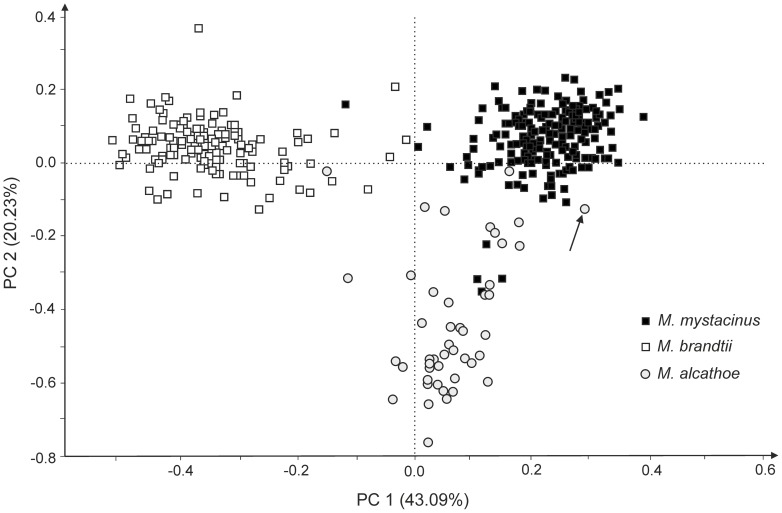
A two-dimensional plot of the principal coordinate analysis (PCA) performed using GENEALEX based on 14 microsatellite loci for M. mystacinus, M. brandtii and M. alcathoe (the percentage of variance for a given PC shown in parentheses).ID codes for particular species are based on mtDNA determination (in 5 males and 1 female of M. brandtii, 2 males of M. mystacinus, and 1 female of M. alcathoe – with an unsuccessful genetic sequencing – only morphological criteria were used; all of them are placed inside their parental groups). The arrow indicates individual no. BW_M01511 (see the results).